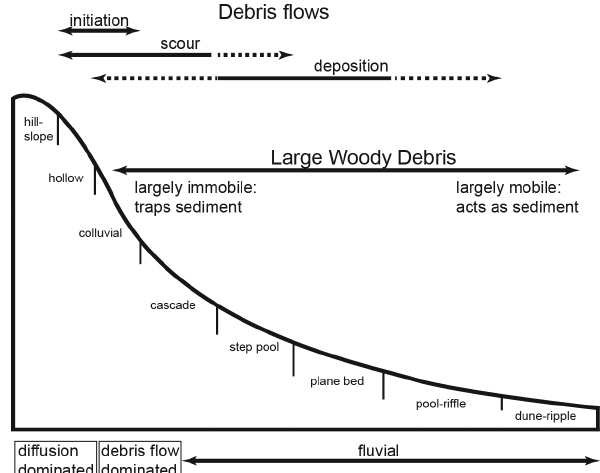
Figure 1. Idealised long profile downslope through the channel net- work showing distribution of channel types and controls on channel processes (from Montgomery and Buffington,